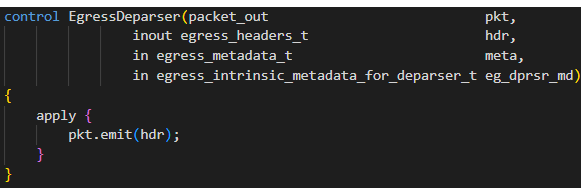
Figure A4. Example